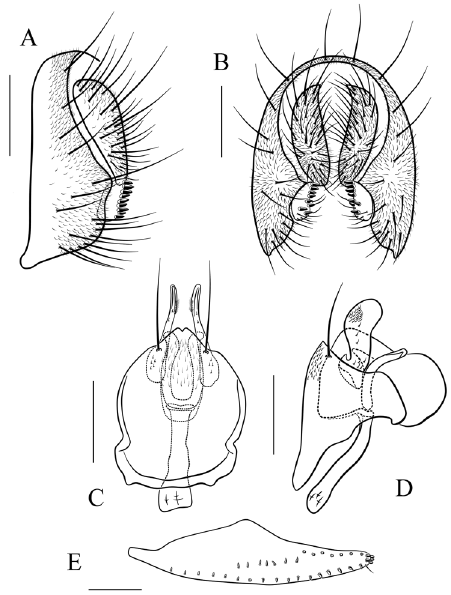
Figure 10. Scaptodrosophila scutellimargo (Duda, 1924). A, B epandrium, surstylus and cercus (lateral and posterior views) C, D hypandrium, parameres, gonopods, aedeagus and aedeagal apodeme (ventral and lateral views) E oviscapt (lateral view). Scale bars 0.1 mm.